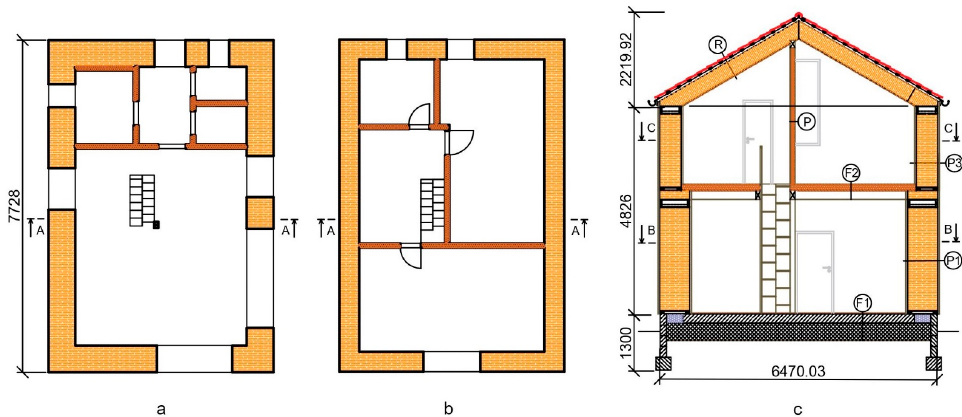
Figure 3. Cross sections of the straw bale residential building (SBRB): ( a ) First floor section B-B; ( b ) Second floor section C-C; ( c ) Cross section A-A. Material composition of marked structures were given in Table 2. Measures are given in milimetres.